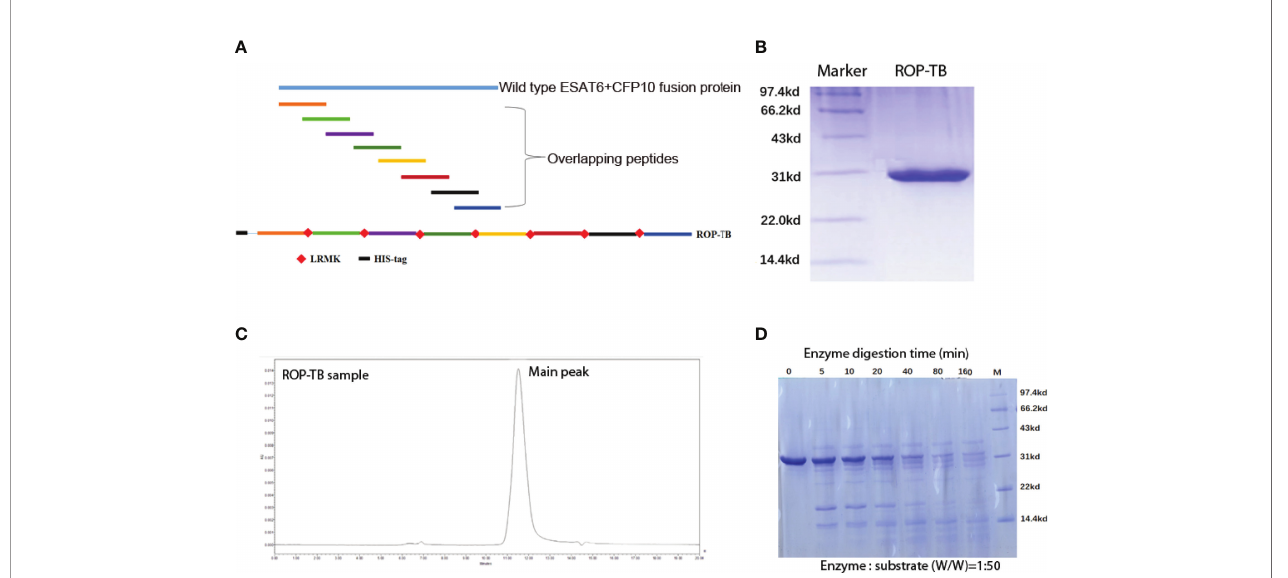
FIGURE 1 | Puri fi cation and digestion of ROP-TB. (A) Schematic presentation of an ROP-TB antigen. The blue line on top represents the sequence of the fusion protein of ESAT-6 and CFP-10; the short colorful lines are the overlapping peptides covering the full sequence length of ESAT-6-CFP-10. The bottom line represents ROP-TB which is a chain of the overlapping peptides linked by LRMK, the substrate of the enzyme Cathepsin S. (B) ROP-TB was expressed by E. coli BL-21 and puri fi ed using a Ni-NTA af fi nity column. (C) After puri fi cation, ROP-TB was analyzed by HPLC to further con fi rm purity. (D) ROP-TB was digested at 37°C by Cathepsin S at 1:50. After digestion, samples were collected at different times and analyzed by SDS-PAGE